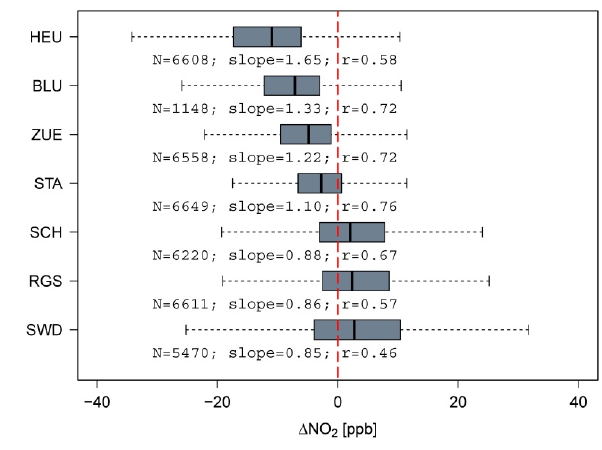
Figure 9. Comparison of simultaneously measured NO 2 (5min av- erage) from the mobile QCLAS and from the CLD in AQM sites irrespective of the location of the tram. N denotes the number of measurements, r is the Pearson correlation coefficient, and slope refers to a regression line through the origin (QCLAS vs.